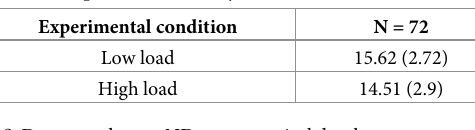
Table 2. Experimental task by load: Mean (standard